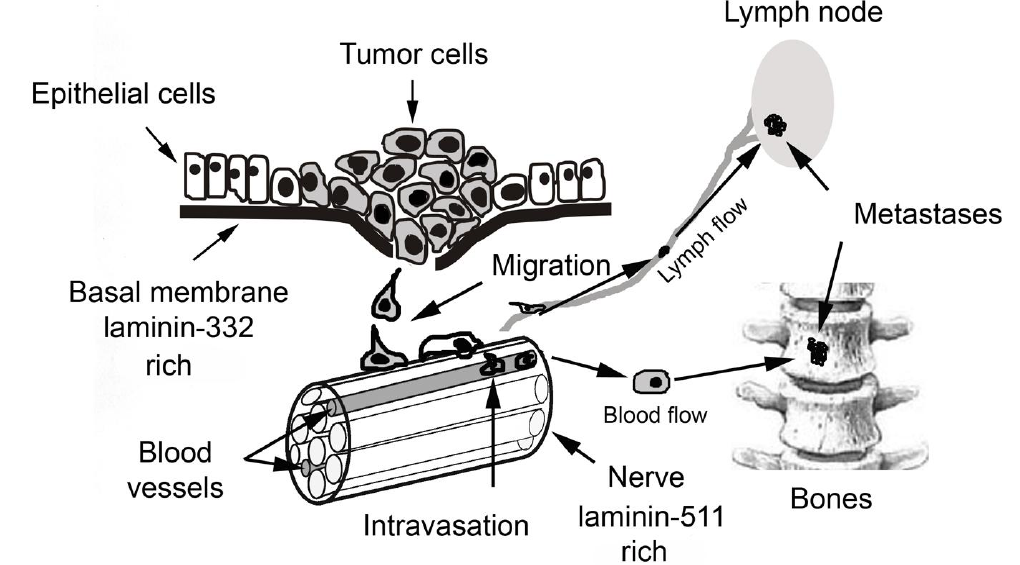
Figure 1. Metastatic cascade of prostate carcinoma (PC). PC cells grow into a